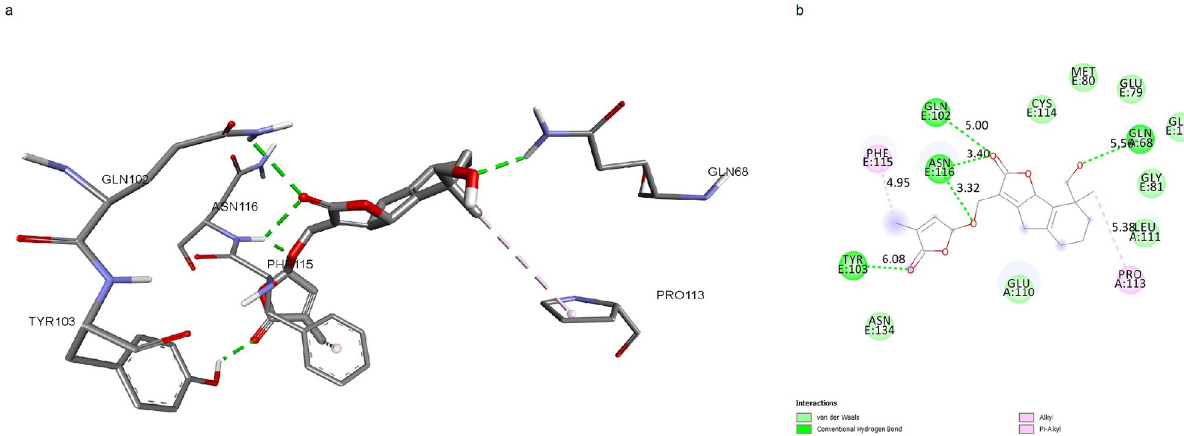
Fig 3. mTNF α -hTNFR1 interaction with Sorgomol. a .3D shape of mTNF α -hTNFR1 interaction with Sorgomol. b . Illustration of hydrophobic bond formation between Sorgomol with the mTNF α -hTNFR1 complex. Sorgomol forms 3 hydrogen bonds with GLN102, ASN116, and TYR103, and 1 π - sigma bond with PHE115 of hTNFR1. It also forms 1 hydrogen bond with GLN68, and 1 π -sigma bond with PRO113 of mTNF α .